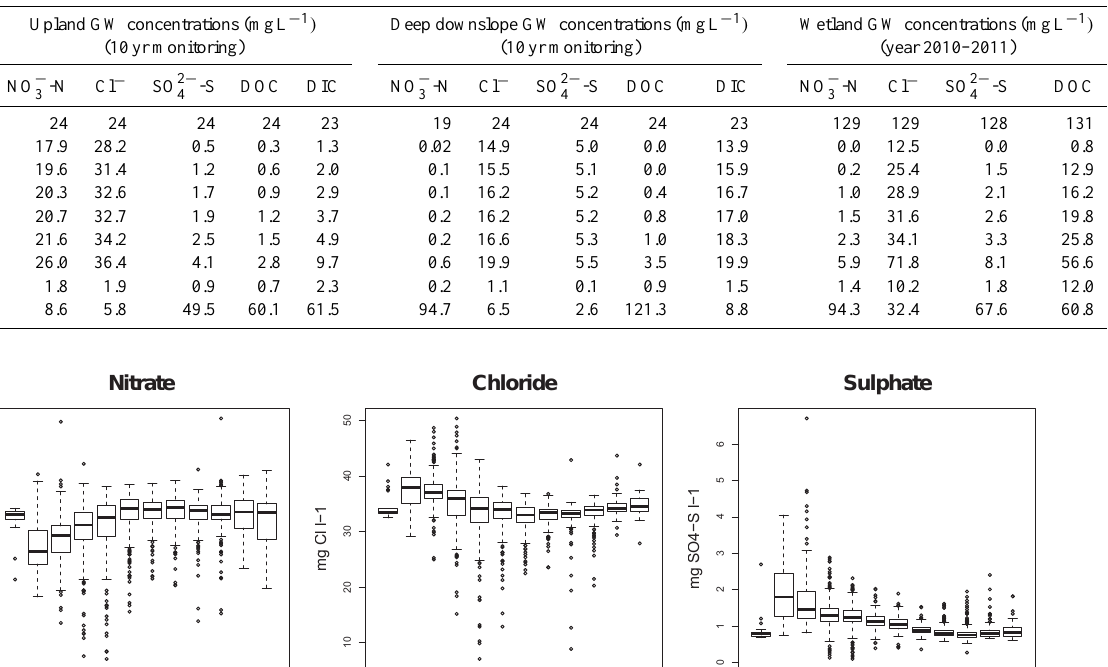
Table 2. Summary statistics for 10yr of deep groundwater concentrations of nitrate, chloride, sulphate, dissolved organic carbon (DOC) and dissolved inorganic carbon (DIC) sampled from the Kervidy-Naizin catchment. (Std–standard deviation; CV–coefficient of variation).